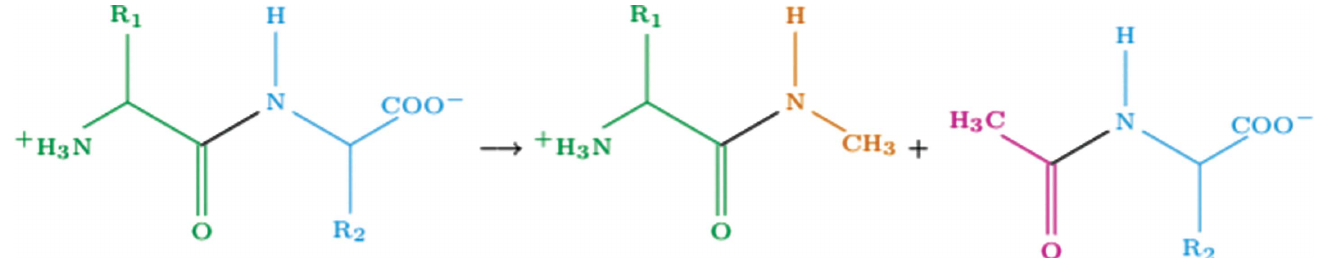
Figure 1 The molecular fractionation with conjugate caps (MFCC) procedure for cutting a dipeptide (left) across the peptide bond (shown in black), producing two fragment molecules (right), which are then ‘capped’ with –CH 3 C O (red) and –NHCH 3 (orange) groups, comprised of the neighbour and next- neighbour non-H atoms.